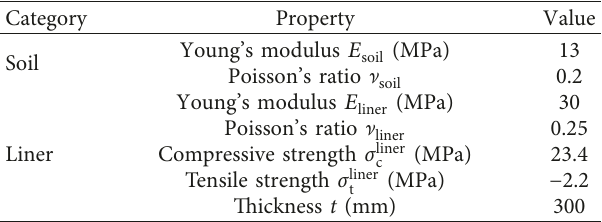
Table 4: Deterministic properties for the real